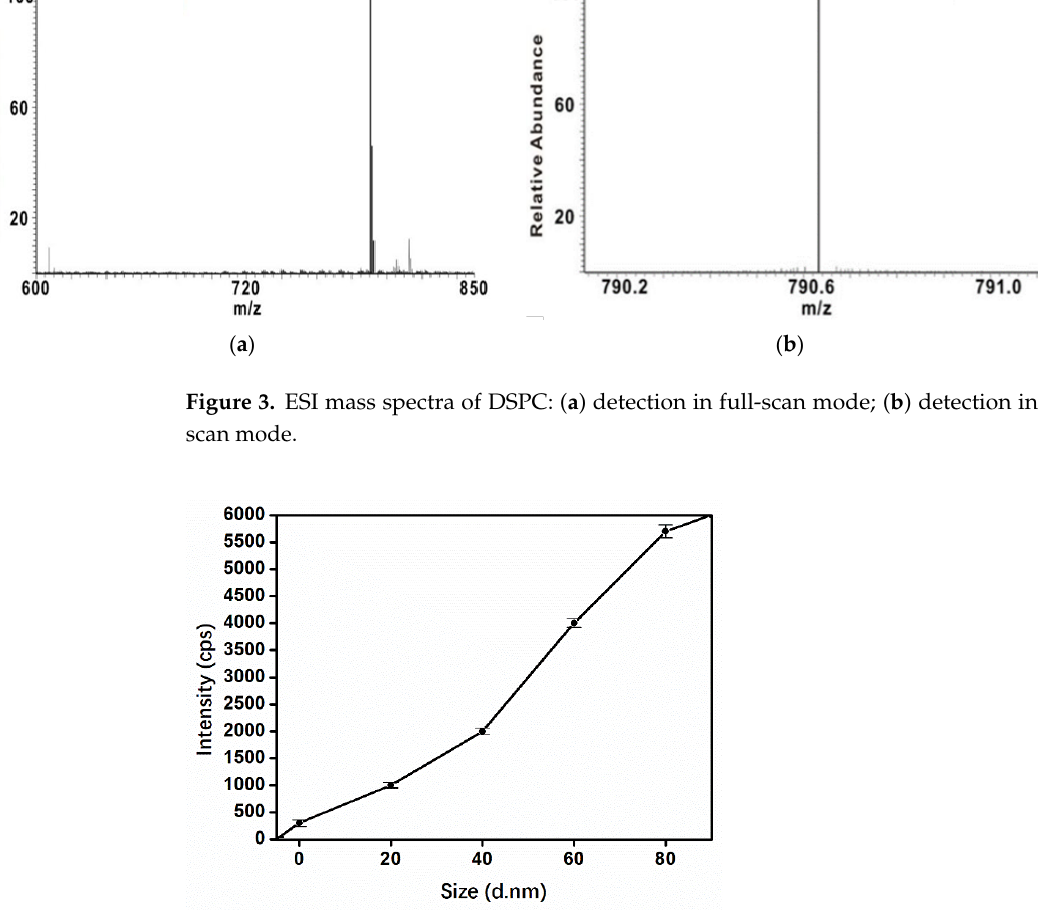
Figure 4. Plot of the intensity of the MS signal versus the size of the